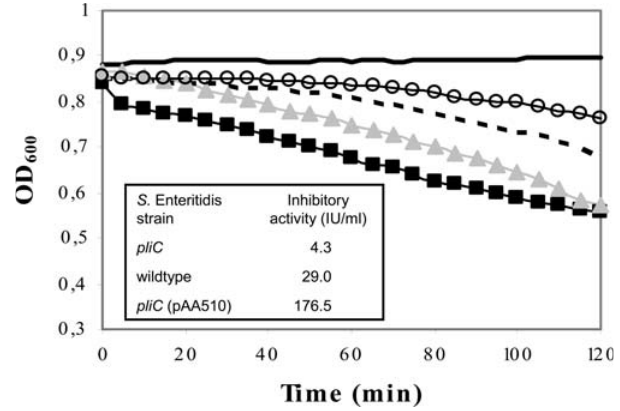
Figure 2. In vitro HEWL inhibitory activity of PliC from S. Enteritidis. Lysis (expressed as OD 600 against time) of M. lysodeikticus cell suspension by 6.6 U/ml HEWL in the absence (- & -) and presence of periplasmic protein extracts of S. Enteritidis pliC (1:2 diluted; - m -), S. Enteritidis (1:10 diluted; —) and S. Enteritidis pliC (pAA510) (1:40 diluted; -o-). Lysozyme inhibitory activity (IU/ml) of undiluted extracts is shown in the table in inset. The control sample (—) consisted of phosphate buffer instead of lysozyme solution added to M. lysodeikticus